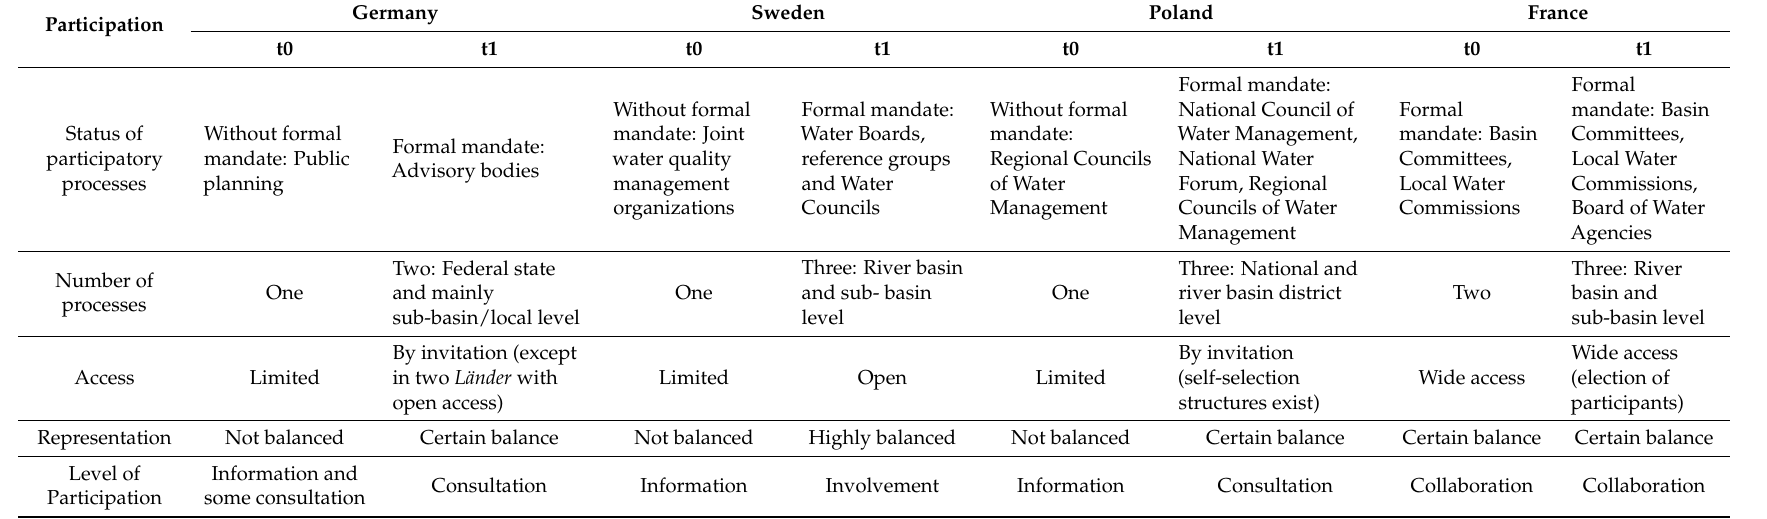
Table A2. Institutional Arrangements for Participation before (t 0 ) and after (t 1 ) the WFD in Four Member